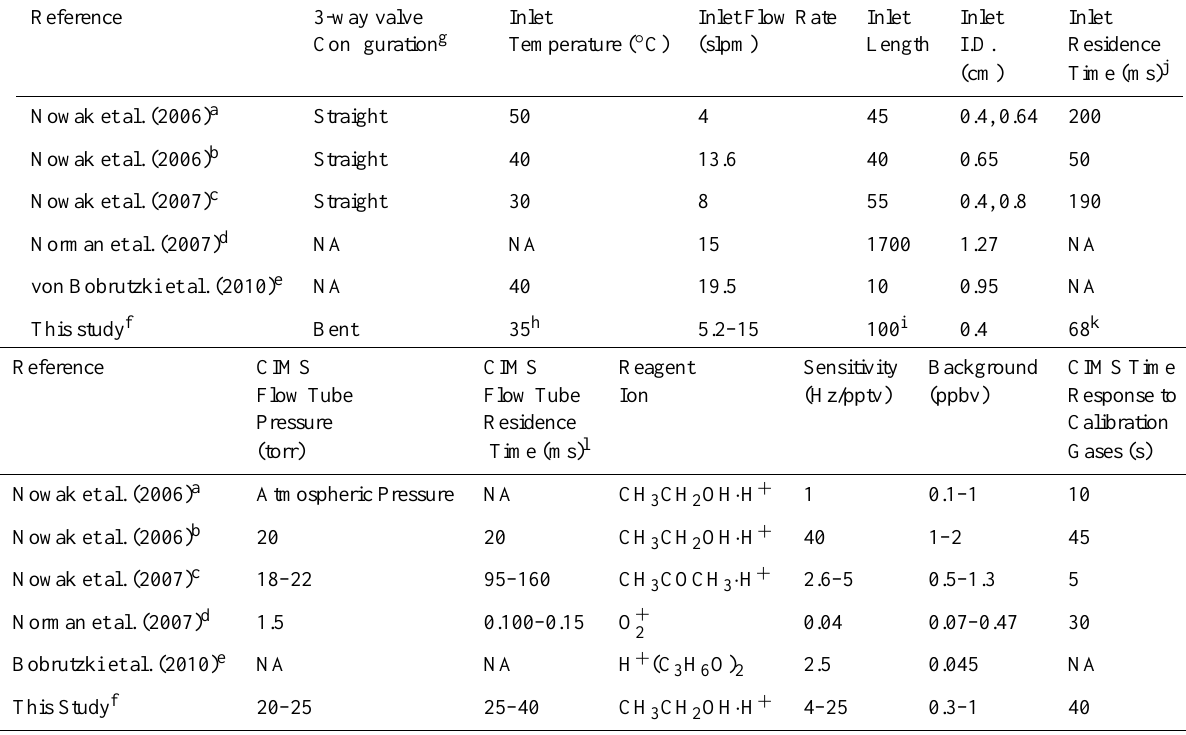
Table 1. A summary of NH 3 -CIMS instruments found in the literature, with regard to sampling inlet and CIMS detection conditions. Included here are the configuration of the 3-way valve used to switch between the ambient and calibration mode; temperature, flow rate, total length and inner diameter of the sampling inlet; residence time for ambient measurements through the inlet; pressure and residence time in the CIMS flow tube reactor; the reagent ion used for analysis; sensitivity, background, and time response of the CIMS